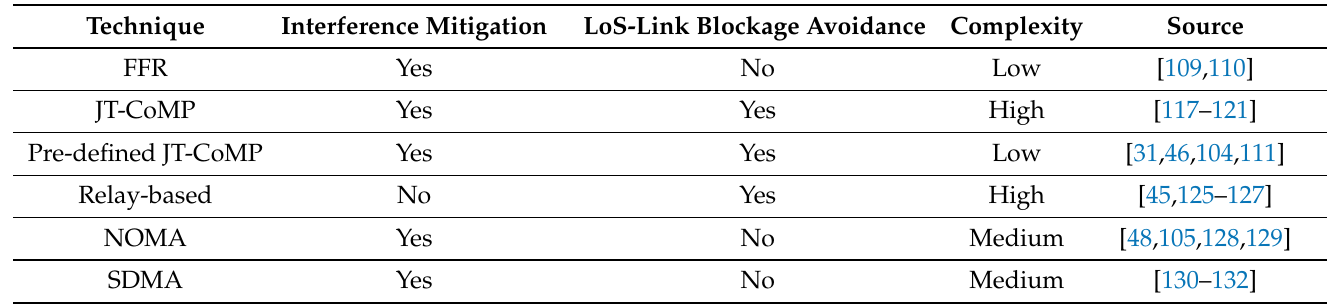
Table 3. VLC cooperative